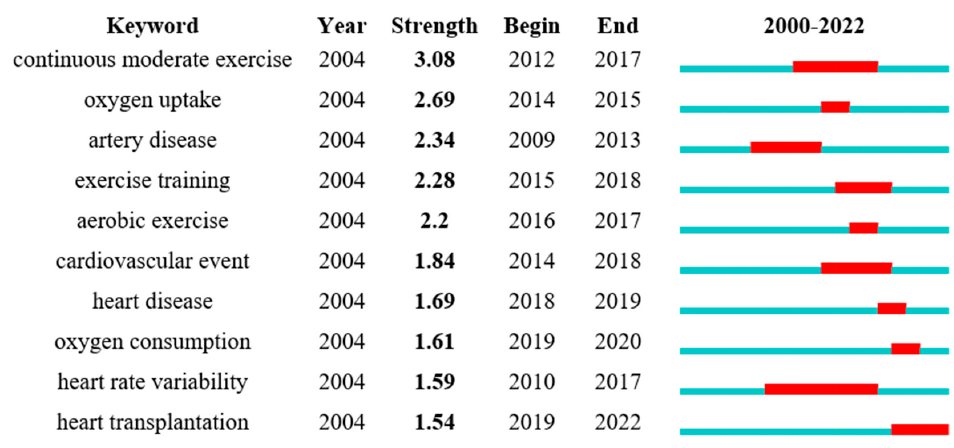
Figure 7. Top 10 keyword bursts.